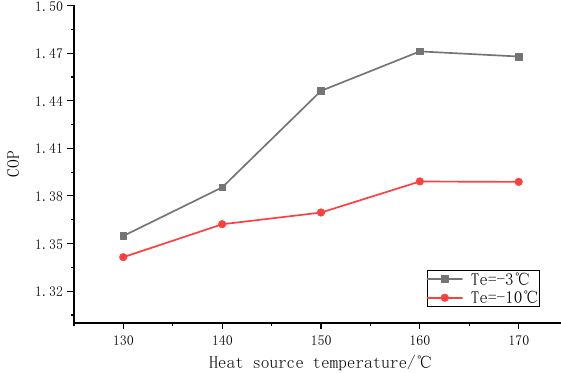
Figure 5. E ff ect of heat source and evaporation temperatures ( T e ) on system Figure 5. Effect of heat source and evaporation temperatures ( T e ) on system performance.